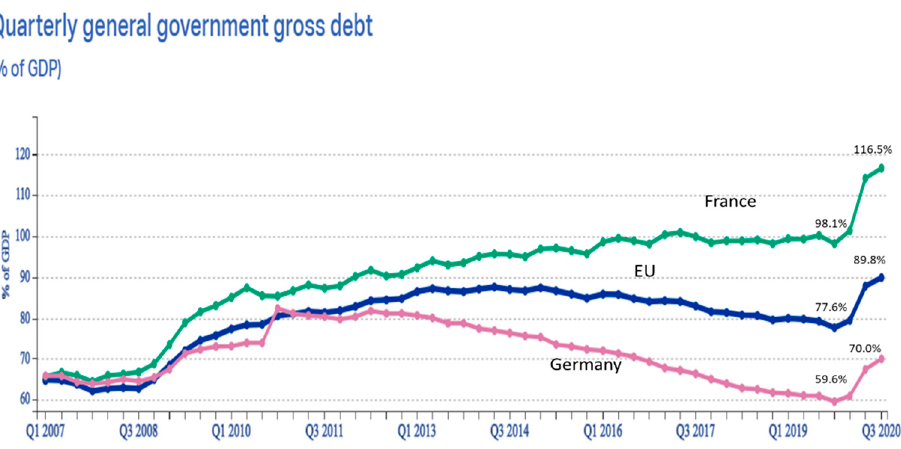
Figure 1. Debt to GDP percentage for EU, France and Germany. Source: EU Statistics.